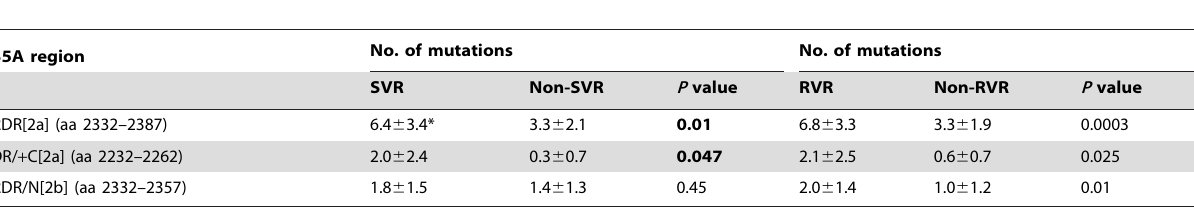
Table 3. Average numbers of aa mutations within IRRDR[2a], ISDR/ + C[2a] and IRRDR/N[2b] of HCV NS5A obtained form pre- treated sera of HCV-2a and -2b-infected patients with SVR, non-SVR, RVR and non-RVR.